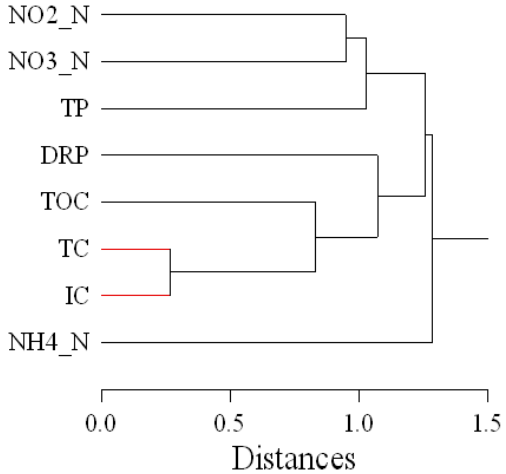
Figure 6. Dendrogram showing the R-mode clustering of the groundwater data Fig. 6. Dendrogram showing the R-mode clustering of the ground- water